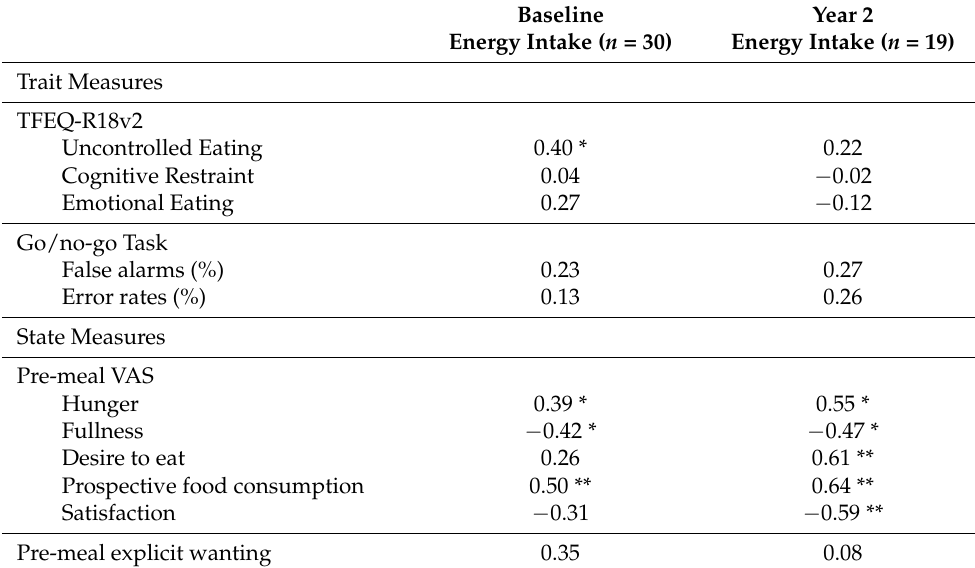
Table 2. Pearson’s correlations between state or trait measures and energy intake (adj. for FFMI) at Baseline and Year 2 follow-up. Abbreviations: Three Factor Eating Questionnaire Revised 18-item